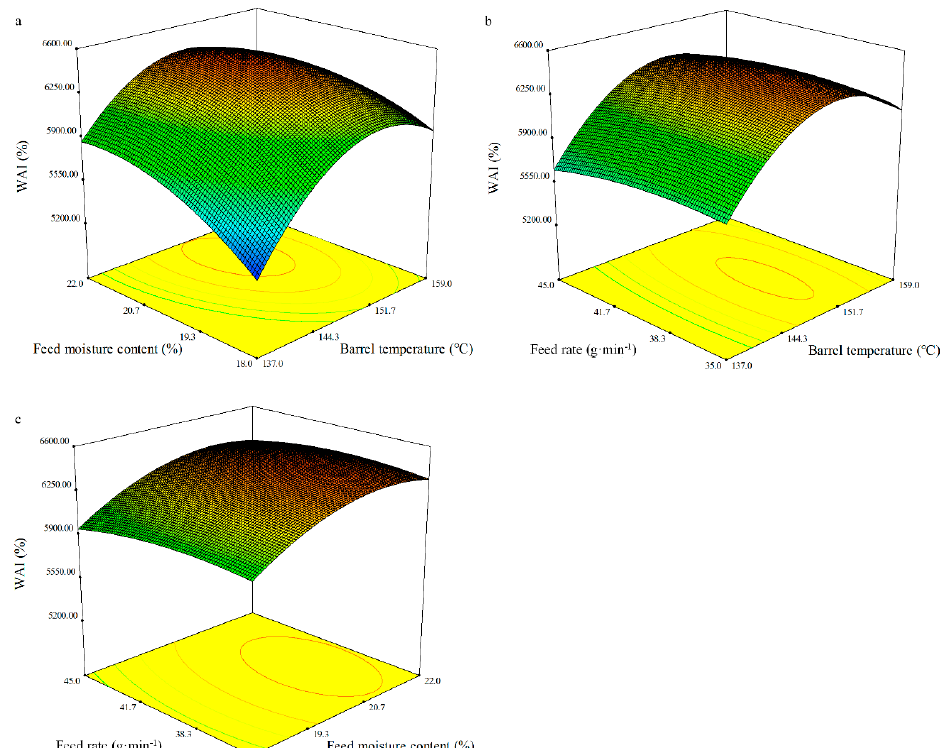
Figure 5. Response surface plot of the WAI of the whole BGW extrudates.